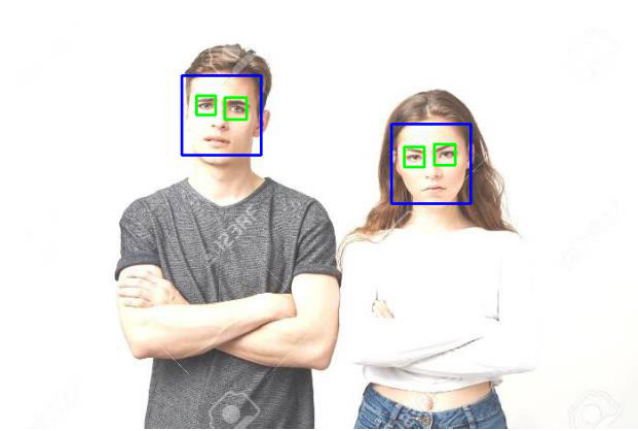
Figure 32. After increasing the brightness of Figure